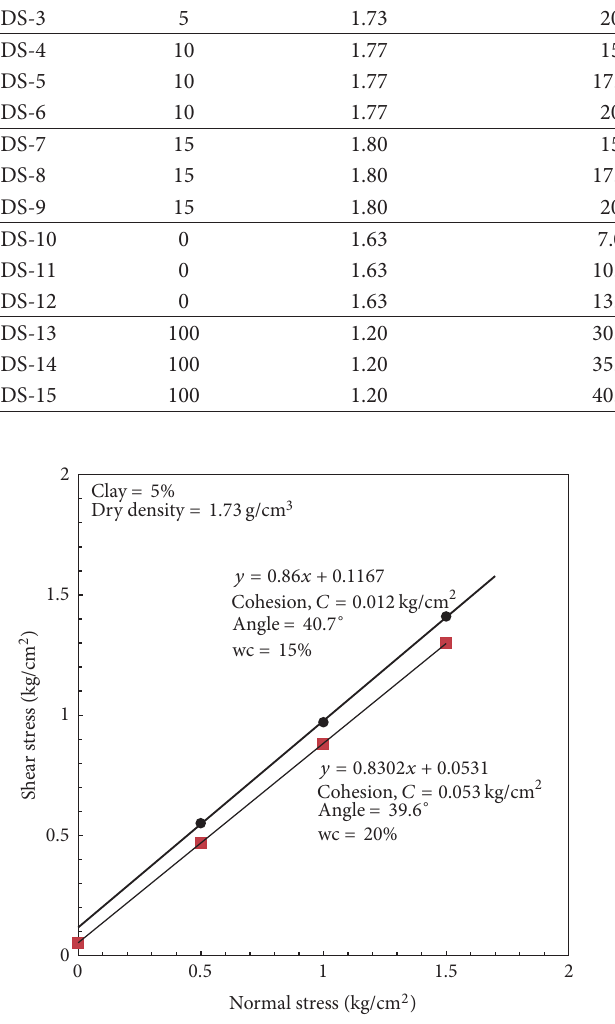
F 6: Shear strength envelope for clay-sand mixture.